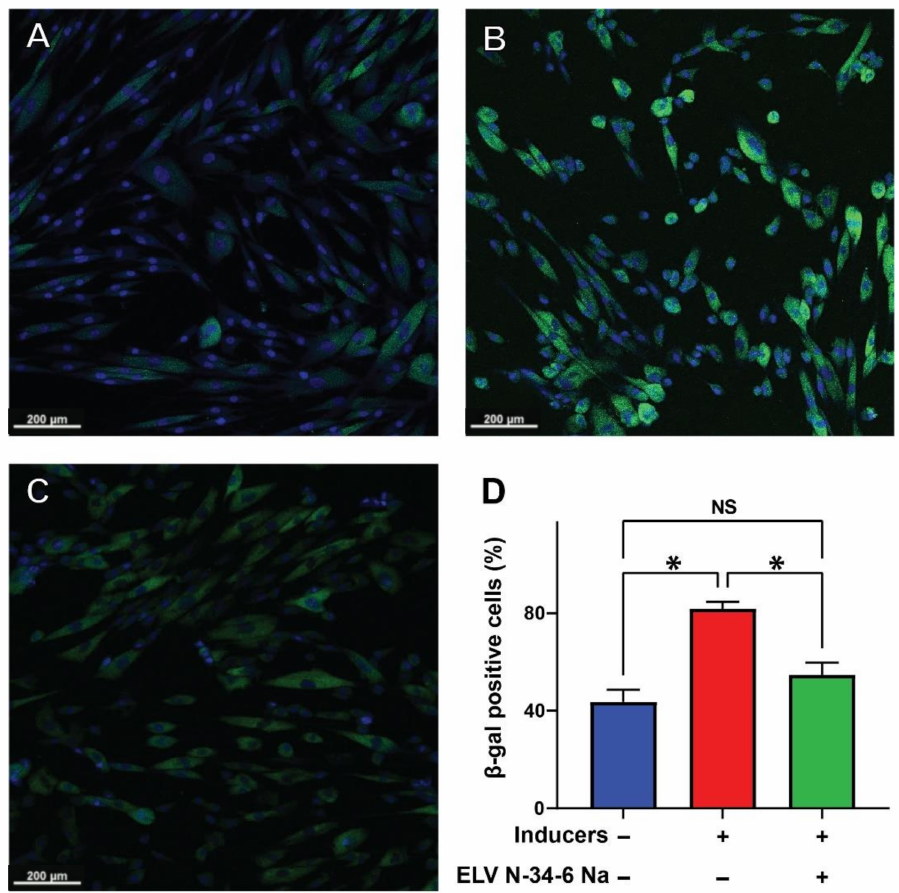
Figure 5. ELVN-34 protect HNEpC from the senescence-associated secretory phenotype (SASP response) . Representative images of HNEpC stained with Hoechst 33342 and spider β -galactosidase— ( A ) untreated (control), ( B ) challenged with HDM (30 µ g/mL), and ( C ) HNEpC treated with HDM and ELVN-34:6 Na (500 nM). ( D ) Quantitative assessment of increased SASP response (measured by the spider β -galactosidase staining) upon HDM exposure (30 µ g/mL). ELVN-34:6 Na (500 nM) treatment reduces the number of beta-gal-positive HNEpC induced by HDM. The results showed the averages of three independent experiments. (* p < 0.05, NS—not